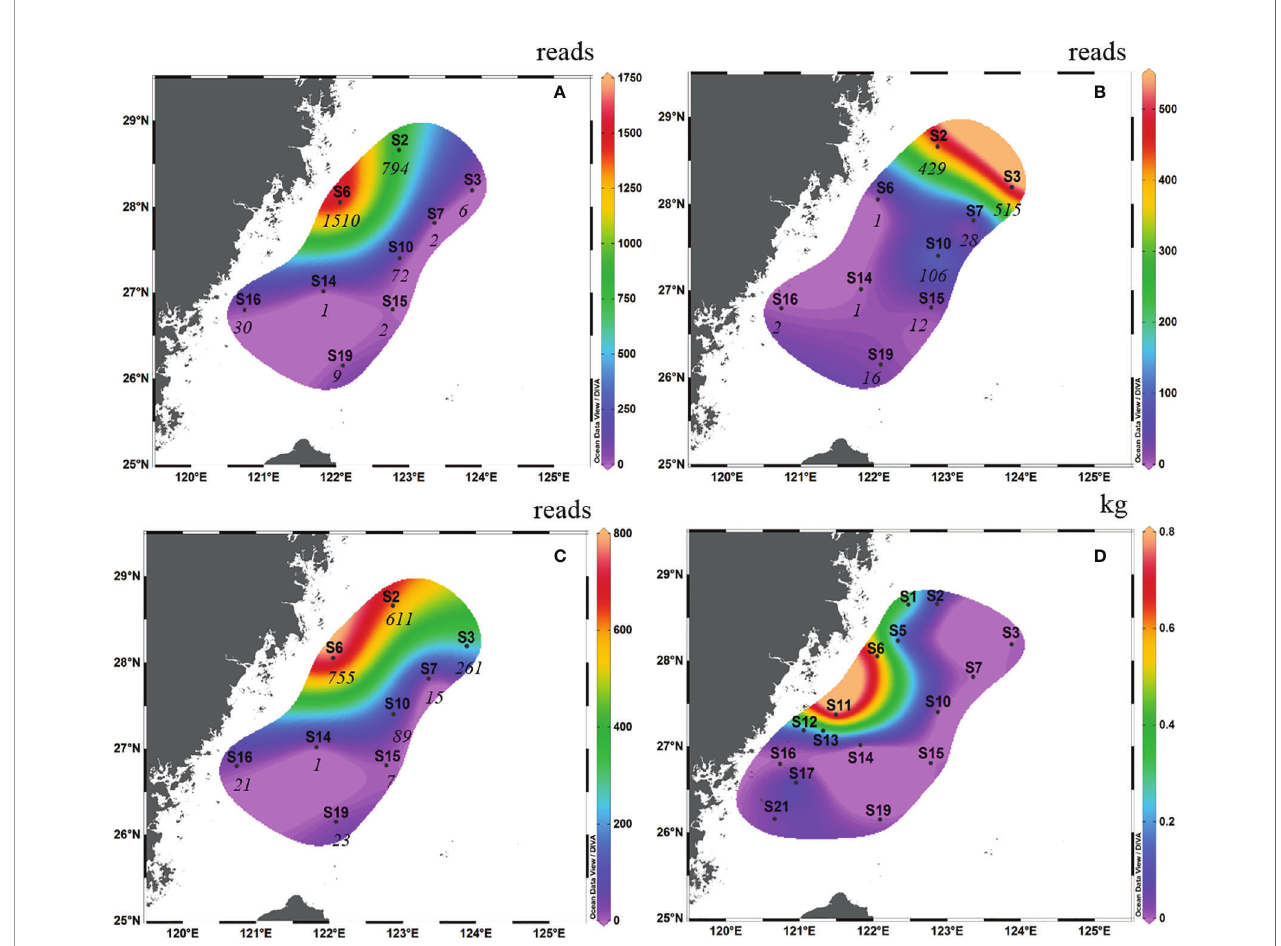
FIGURE 3 | Contour map of Larimichthys crocea in the East China Sea in spring 2019 based on metabarcoding analysis from surface samples (A) , bottom samples (B) and the average abundance between surface samples and bottom samples (C) , and based on capture biomass from fi shing surveys (D) . The italicized numbers indicate the OTU abundance of L. crocea